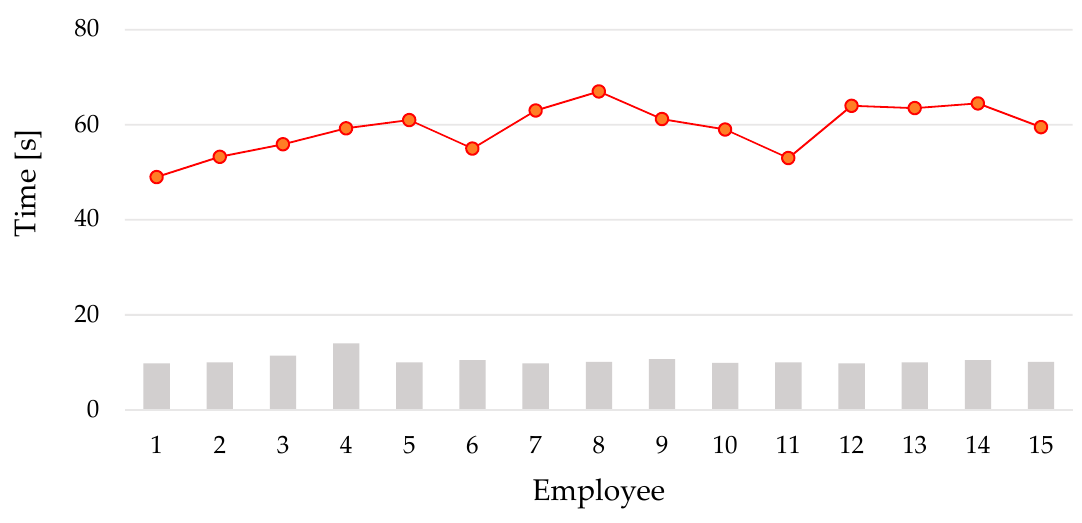
Table 6. Frequency of using the tongs.